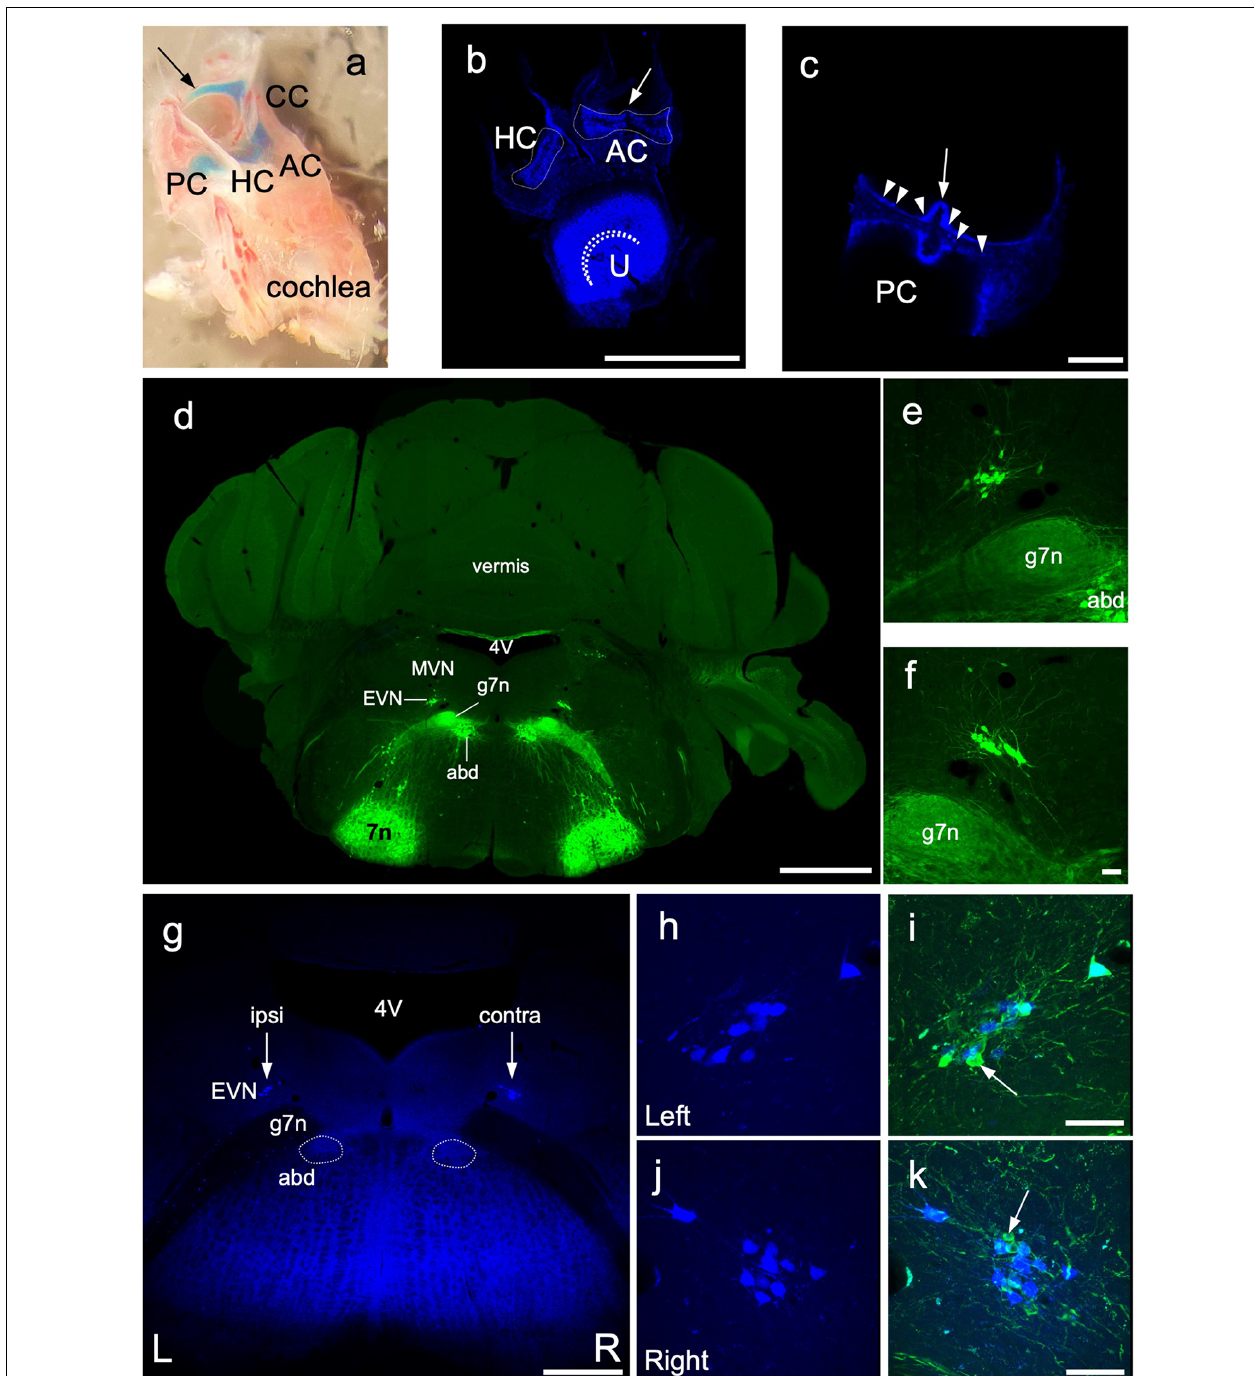
FIGURE 6 | Retrograde labeling of central EVN neurons. Fluoro Gold fluorescent retrograde tracer was injected unilaterally in the inner ear through the posterior semicircular canal and the efferent neurons were traced back retrogradely in the EVN on both sides. (A) Dissected bony inner ear following Fast Green dye injection through the posterior semicircular canal, arrow—injection site, PC, posterior semicircular canal, CC, common crus; AC, anterior crista; HC, horizontal crista. (B,C) Maximum projection image from z-stacks of the triad and posterior crista following dissections of a Fluoro Gold injected inner ear, dashed line outlines the vestibular cristae. curved dashed line—utricular striola, AC, anterior crista; HC, horizontal crista; U, utricle; arrow—eminentia cruciata; arrowheads—fluorescent neuroepithelium. Scale bar (B) : 500 µ m, Scale bar (C) : 100 µ m. (D) Photo-merged image of transgenic Chat-gCaMP6 f mouse used for retrograde tracing and EVN cell counting. The ChAT dependent GCaMP6 fast expression was visualized by GFP immunolabeling in green. 4V—4th ventricle, MVN—medial vestibular nucleus,